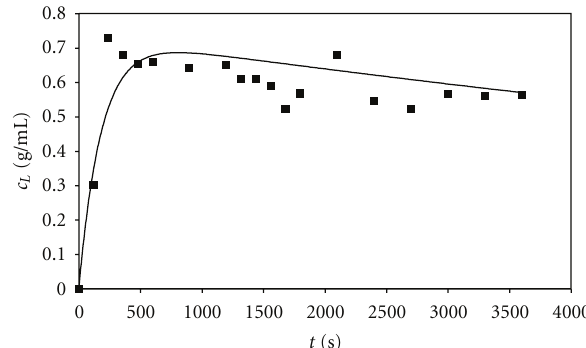
Figure 4: Evolution of oil content at the exit of the extraction column for hydrolyzed